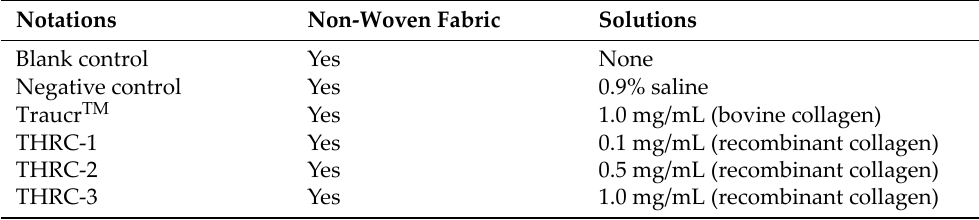
Table 3. Compositions of the control and test dressings on a microneedle‑injured rat